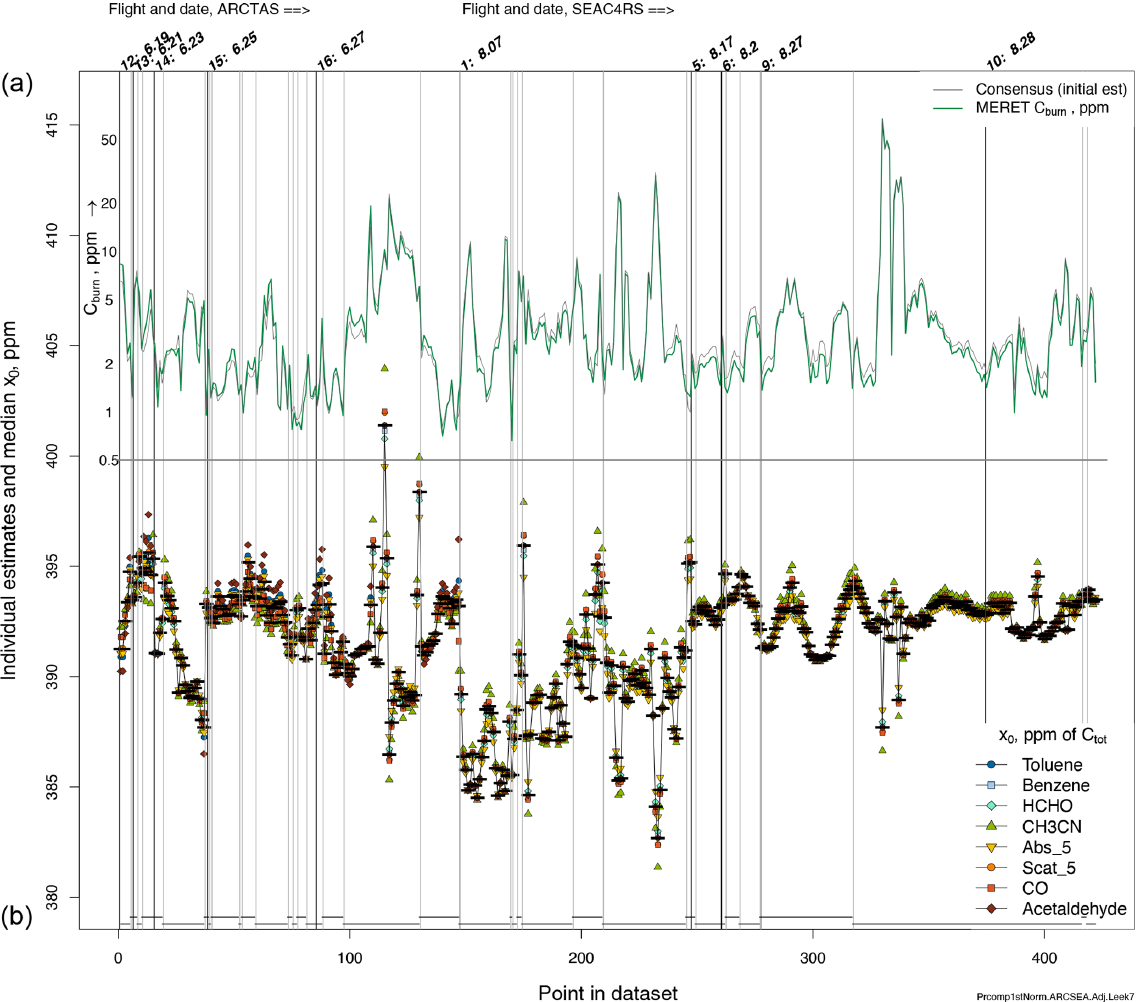
= CO + CO concentrations implied based on the eight fire tracers indicated in the legend. Figure 9. (b) Estimates of the 422 background ˆ x 0 2 i Contributing individual estimates ˆ x 0 are shown by overlapping colored points, with the median estimate ˆ x 0 indicated by a black bar. Usually ij i the colored points overlap closely; this indicates strong agreement. (a) Estimates of C burn = x i − ˆ x 0 indicators of fuel carbon burned, in the i thick green line. The preliminary estimate of C burn based on the consensus of tracer deviations (without variable EnR estimates) is also shown in a thin line. A scale factor, maximizing overlap with the thick line, was necessarily estimated by regression. Flight days are indicated by the days marked on the top axes, and individual plumes, separated by nonplume concentrations of longer than 10min, are shown as vertical separator lines. A set of horizontal lines at ∼ 400ppm indicate selected intervals for optimizing numerics (see text, Sect. 6.3, item